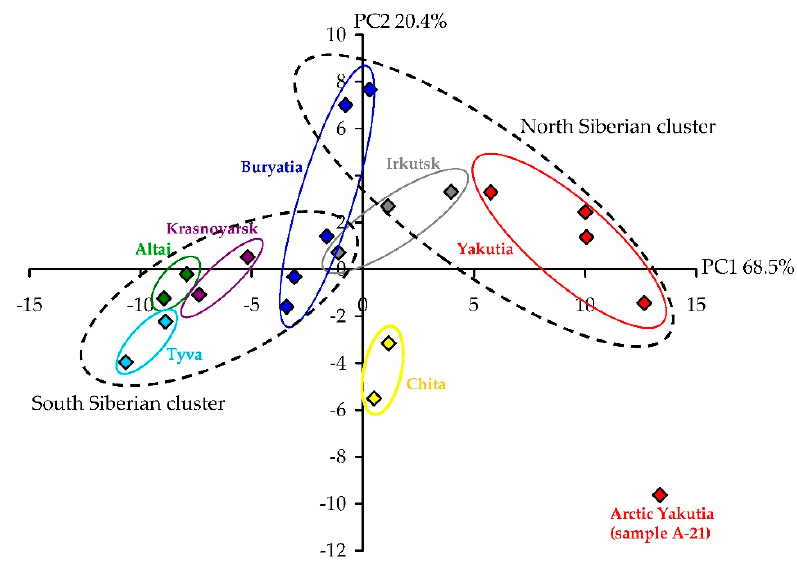
Figure 4. Results of principal component analysis (PCA) used the content of flavonoids and caffeoylquinic acids in the herb of 21 samples of A. frigida .